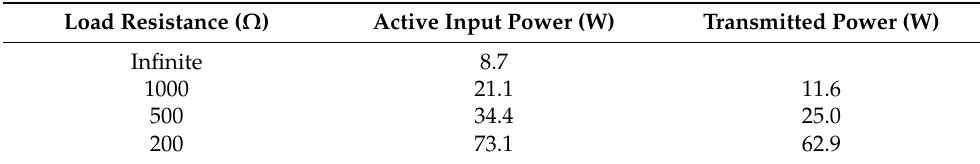
Table 2. Relationship between powers and load